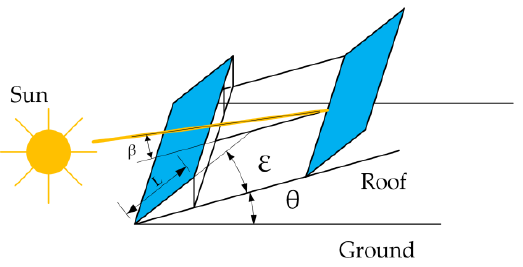
Figure 3. Schematic diagram of PV modules installated on a pitched roof.